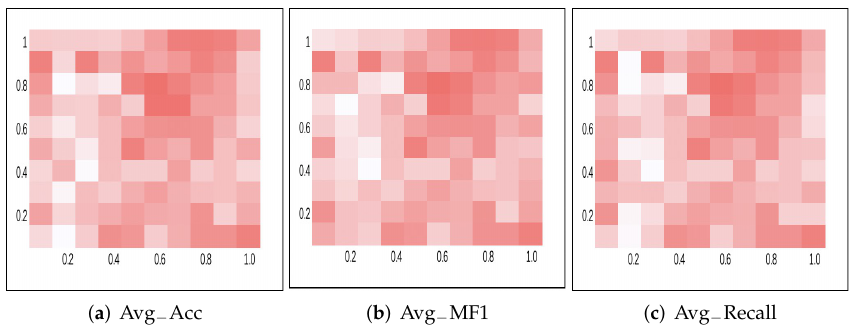
Figure 14. The influence of α 1 and α 2 on the Avg − MF1, Avg − Acc and Avg − Recall of the dataset